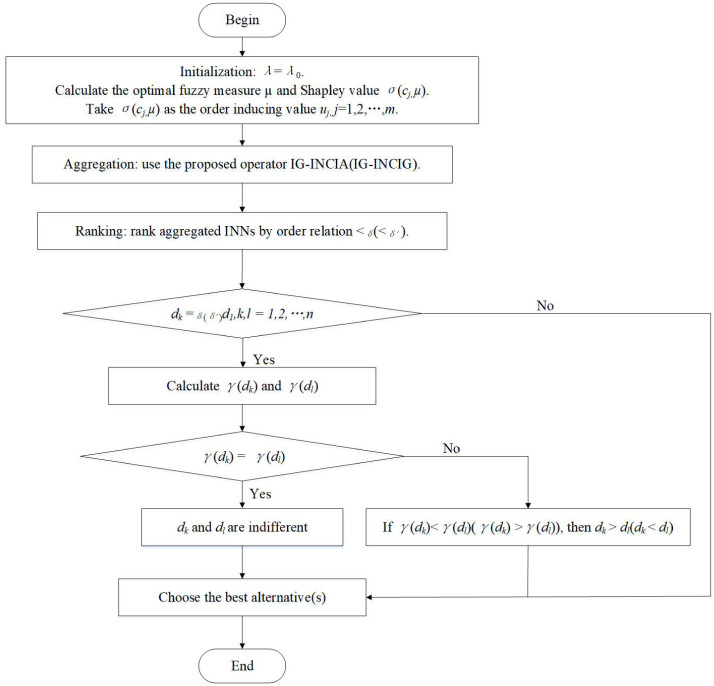
The flow chart of the proposed MCDM method.